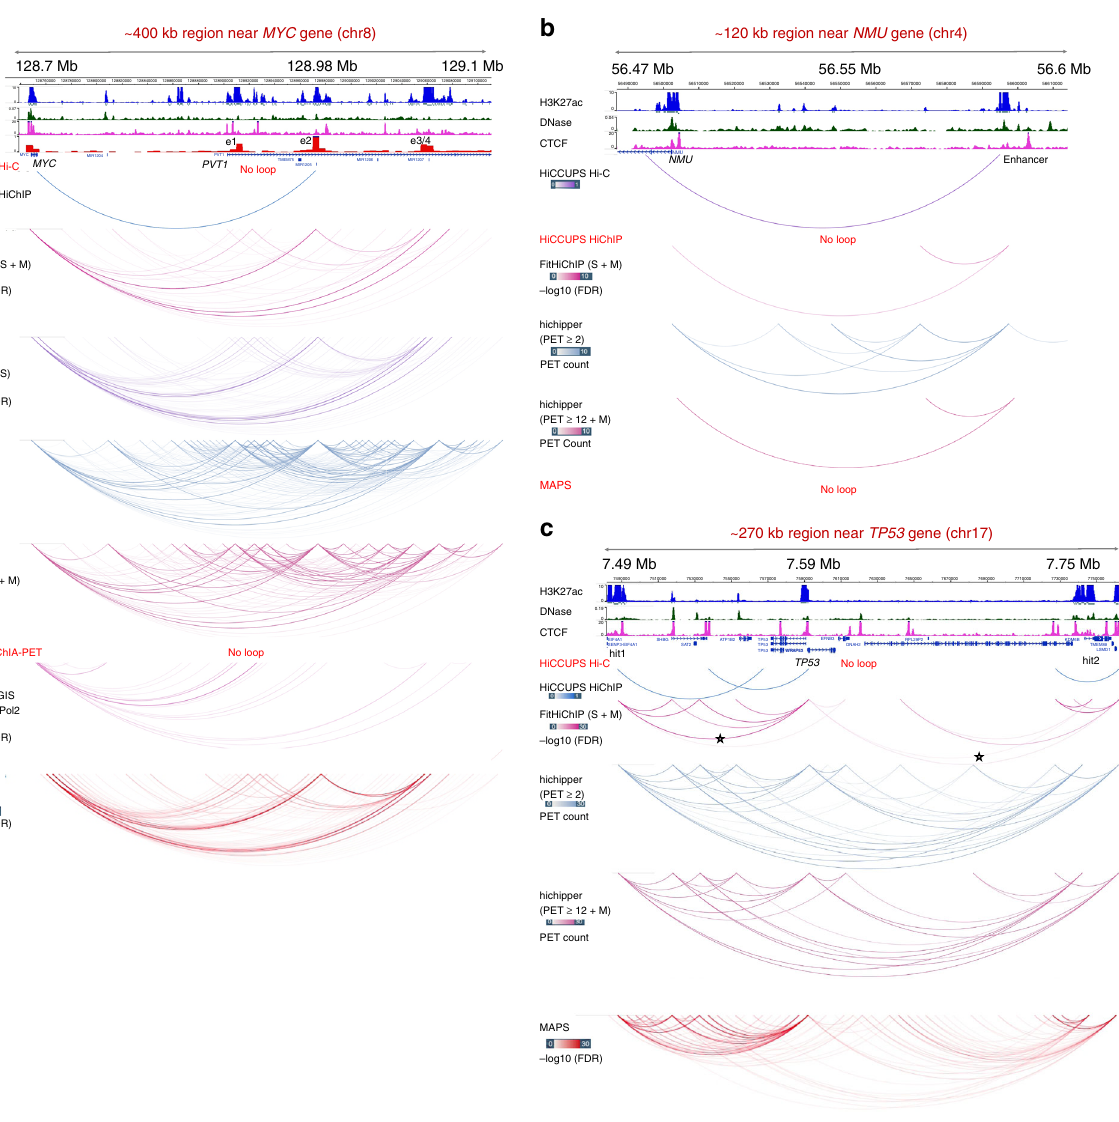
Fig. 4 FitHiChIP recovers independently validated long-range interactions. a : A CRISPRi (clustered regularly interspaced short palindromic repeats interference) screen for MYC locus on K562 cells identi fi ed seven different enhancer regions 21 , four of which are shown here and the remaining three can be seen in Supplementary Fig. 26, which have impact on MYC expression when inhibited by a KRAB-dCas9 system (track for CRISPRi score). b A single-cell CRISPR screen in K562 cells identi fi ed a strong link between expression of NMU gene and an enhancer region ~100 kb upstream 24 . c Two regions identi fi ed by super-enhancer and broad domain analysis coupled with RNA Pol II ChIA-PET data were con fi rmed to interact with the TP53 promoter (loops indicated by stars) in K562 cells using EpiSwitch baits 22 . All browser views were generated using WashU Epigenome Browser 46 . For all fi gures H3K27ac HiChIP data from K562 cells were used for FitHiChIP, hichipper, MAPS, and HiCCUPS HiChIP. Source data are provided as a Source Data fi